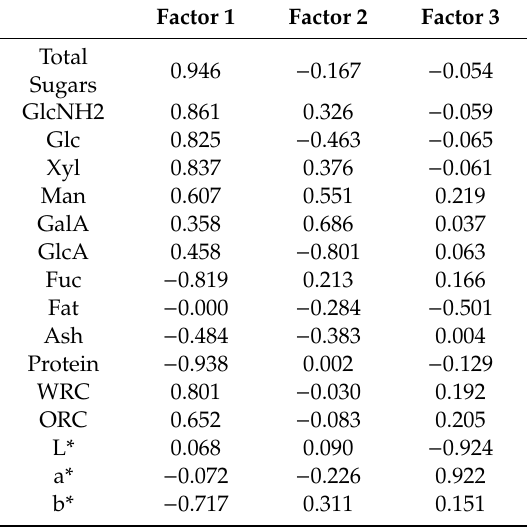
Table A2. Factor-variable correlations (factor loadings), based on